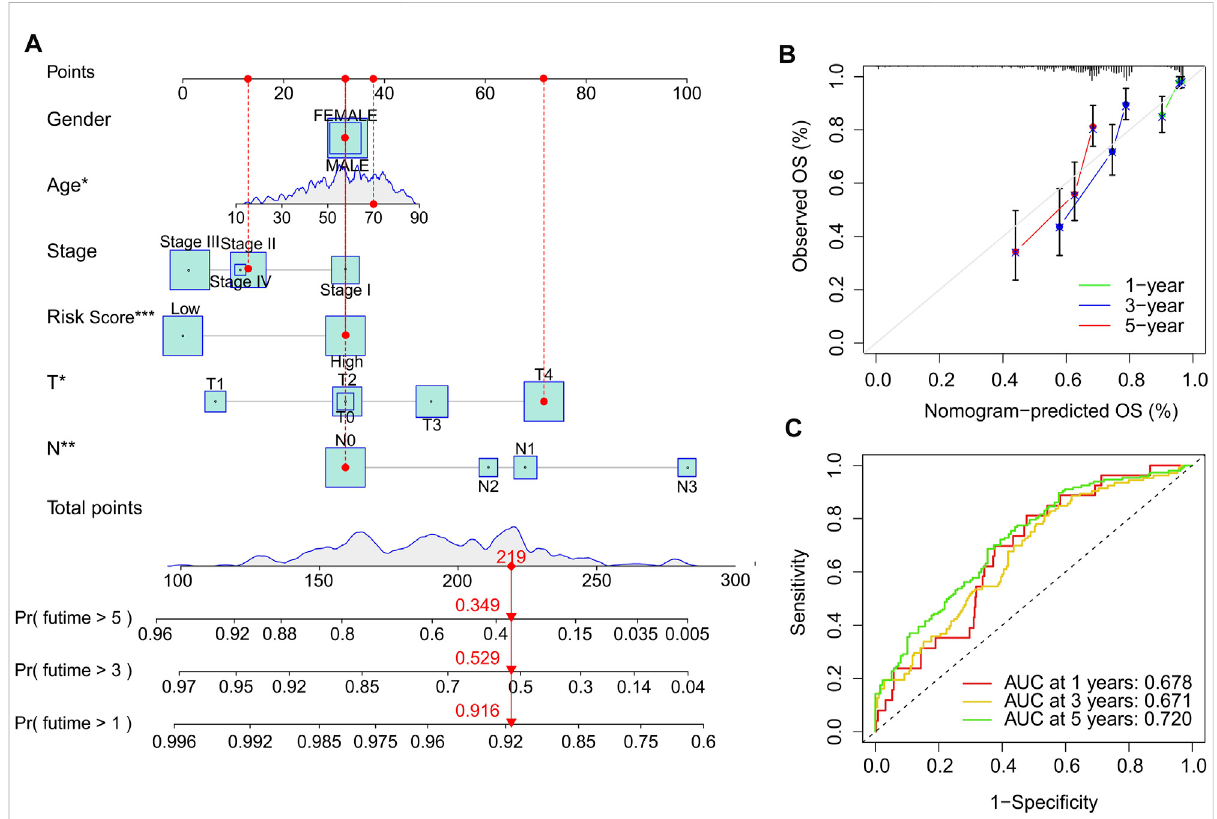
FIGURE 6 Construction nomogram of cuproptosis-related lncRNAs prognostic signatures and clinicopathological characteristics. (A) Nomogram construction of risk scores and other clinicopathological characteristics to predict three- and 5-year overall survival rate of CM patients. (B) Calibration curve revealed the accuracy between predictive power and actual survival of 1-, three- and 5-year. (C) Time-dependent ROC curve shows the AUC at 1-, 3-, and